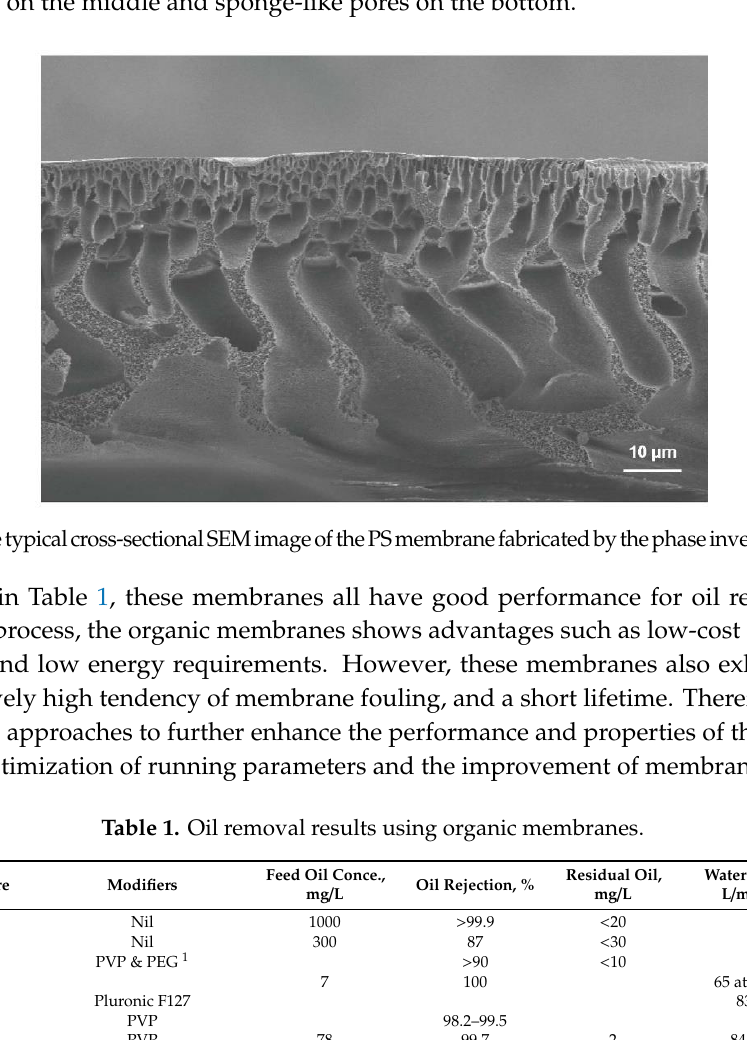
Figure 2. The classification of membranes, adapted from [19] .